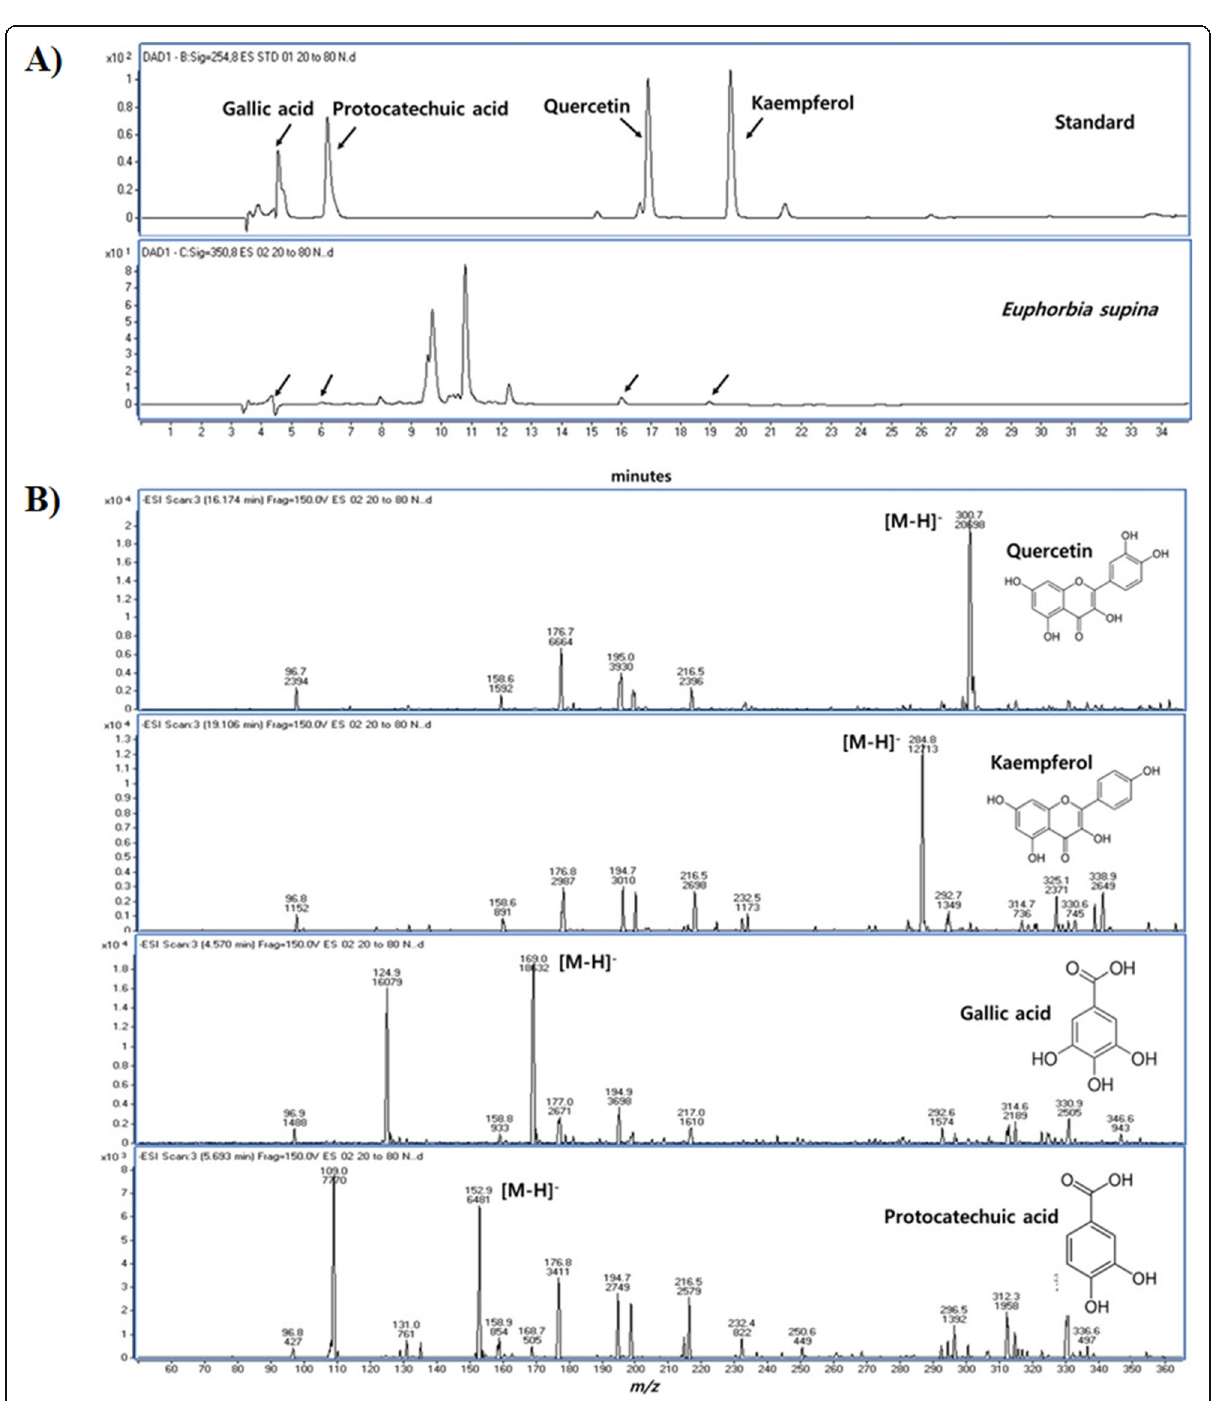
Fig. 6 HPLC chromatogram of standards and Euphorbia supina ( a ), mass scan of quercetin, kaempferol, gallic acid and protocatechuic acid ( b